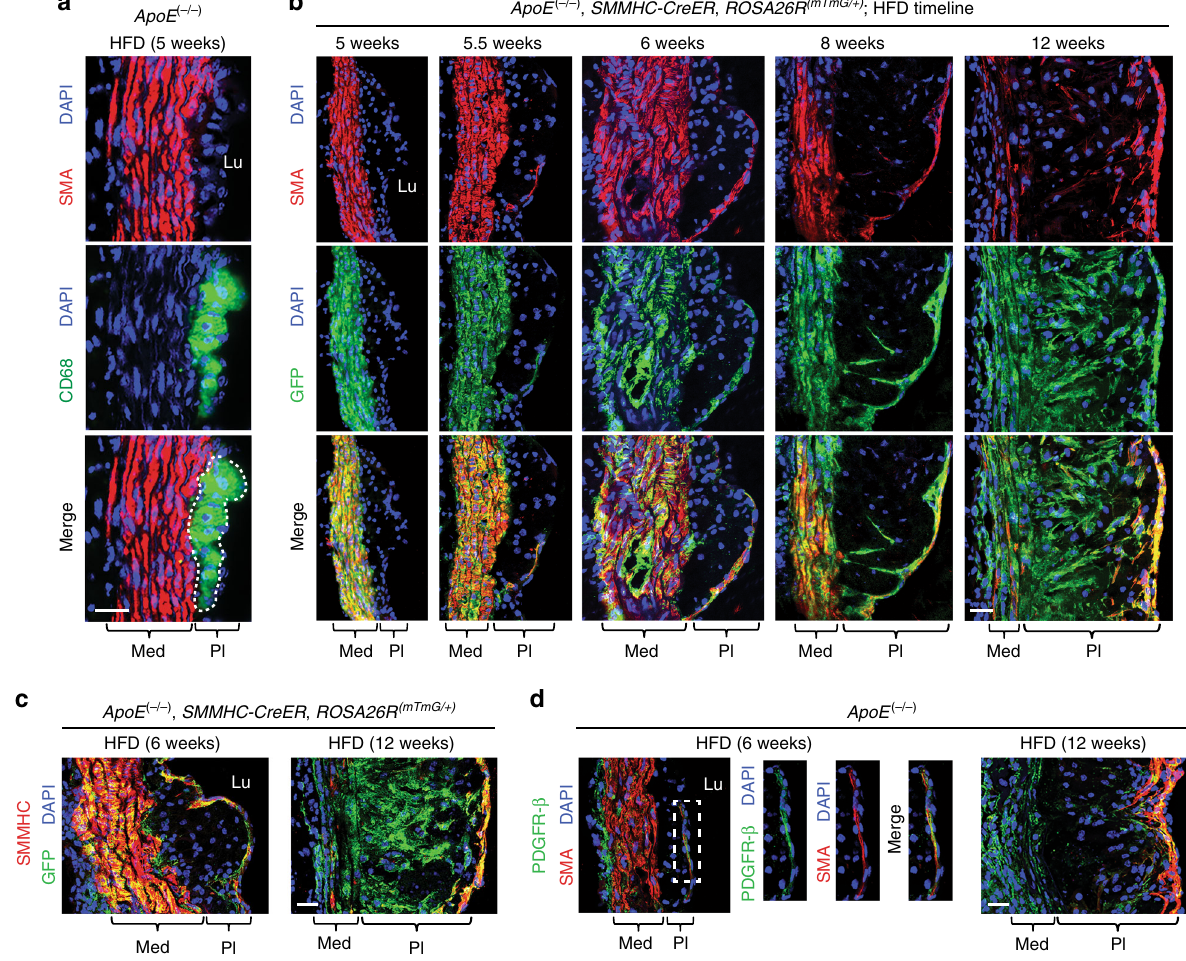
Fig. 3 Smooth muscle-derived cells initially coat the cap of the plaque and then invade the core and dedifferentiate. Transverse aortic root sections of mice fed a HFD for 5 – 12 weeks as indicated were immunostained. a , d Sections from ApoE ( − / − ) mice were stained for SMA, nuclei (DAPI), and either CD68 ( a ) or PDGFR- β ( d ). b , c Prior to high fat feeding, ApoE ( − / − ) , SMMHC - CreER T2 , ROSA26R ( mTmG / + ) were induced with tamoxifen, and sections were stained for GFP (fate marker), nuclei (DAPI), and either SMA ( b ) or SMMHC ( c ). Results are representative of n = 5 mice. Lu, aortic lumen; Med, tunica media; Pl, plaque. Scale bars, 25 μ